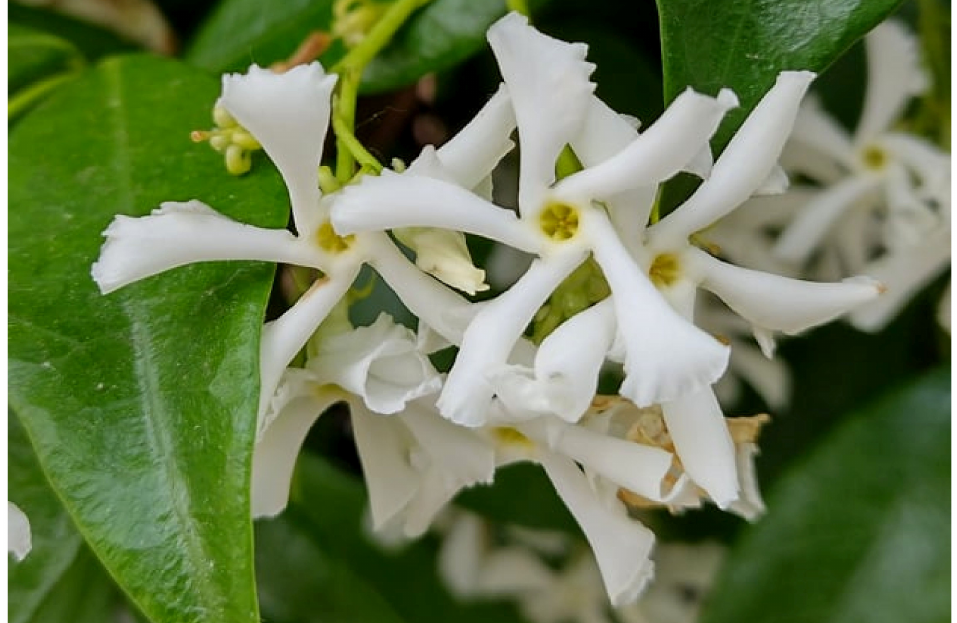
Figure 50. Trachelospermum jasminoides on cliff along Acqua Mariana channel (Acquedotti